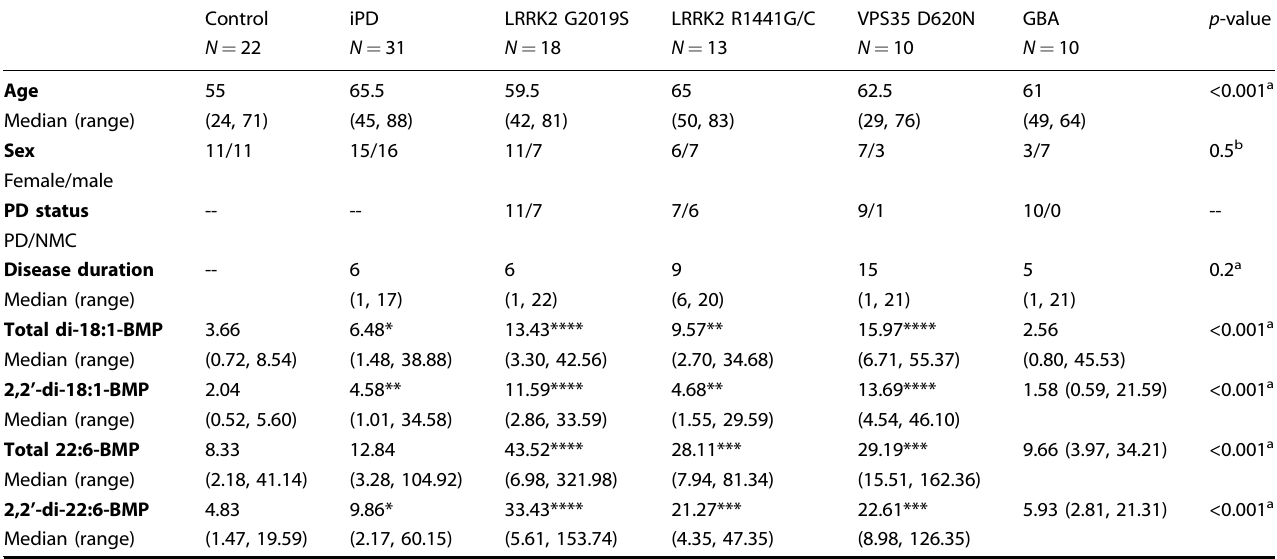
Table 1. Demographic information and urine BMP levels in study